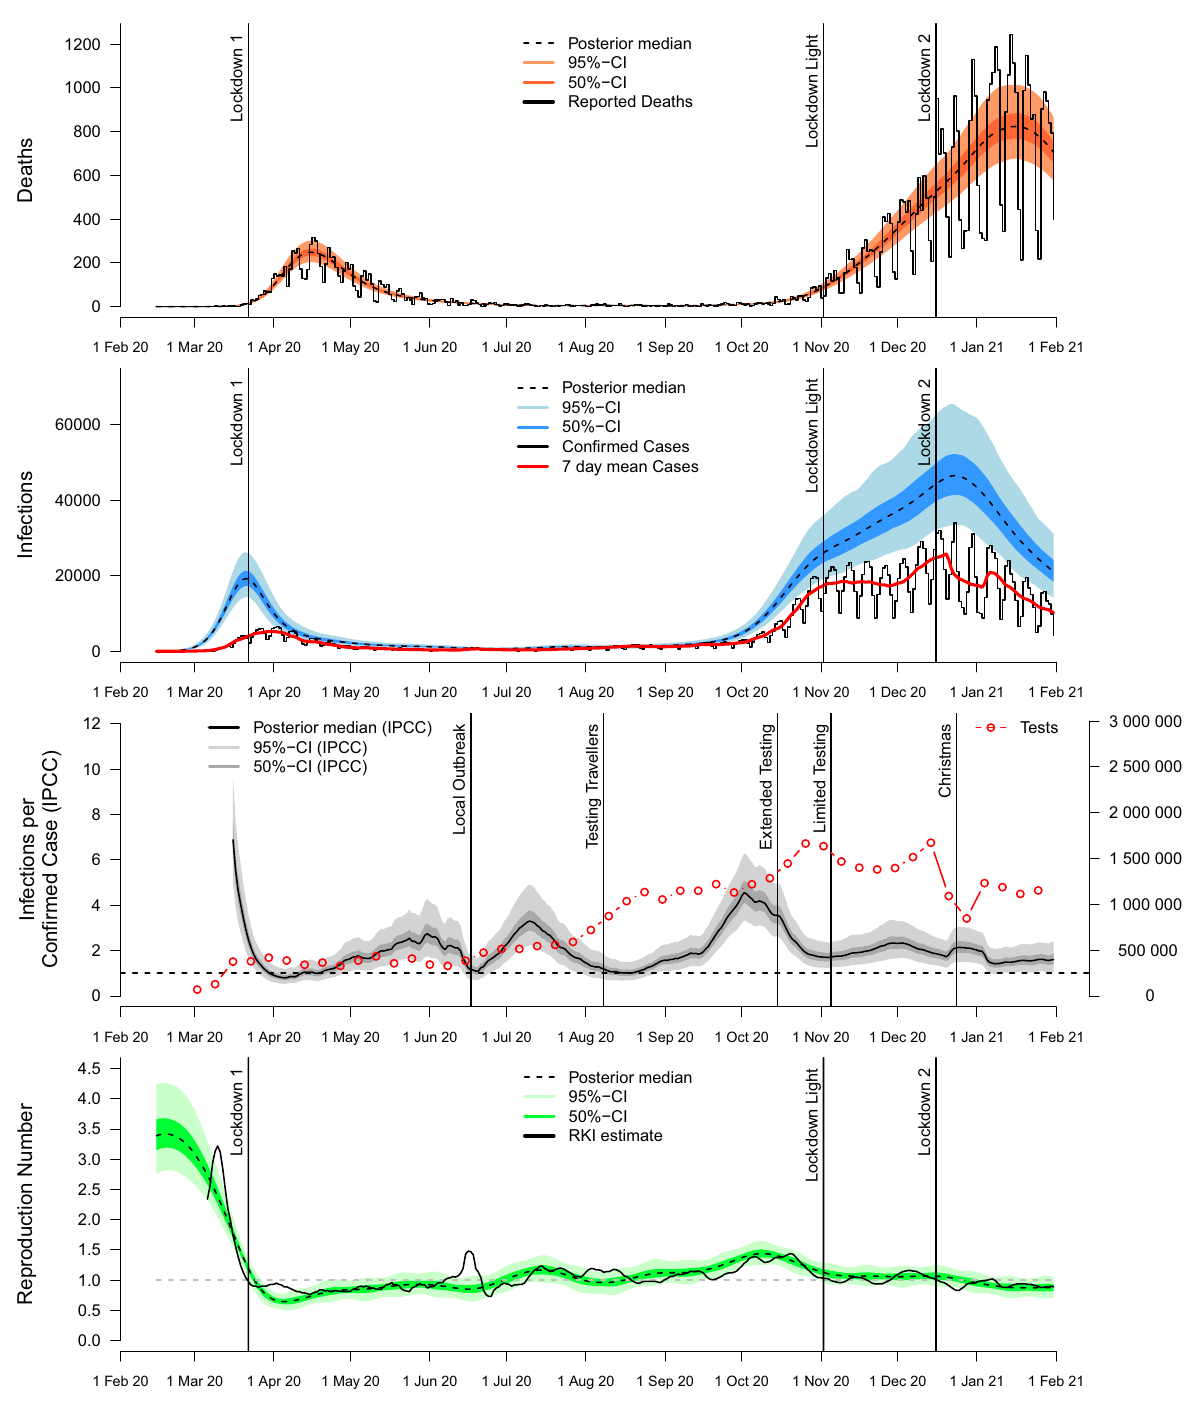
Figure 2. Results for the course of the COVID-19 pandemic in Germany via spline-based hierarchical modelling of death counts (cf. Fig. 1) using age-specific IFR estimates from Brazeau et al. 24 . Our model provides estimates of total numbers of infections over time (second graph) and of infections per confirmed case (IPCC) as a time-varying factor for dark figures of infections (third graph). By disentangling effects of changes in testing from transmission dynamics, estimates of our model for the effective reproduction number based on death counts tend to be more robust compared to RKI estimates based on confirmed cases (fourth graph). Model estimates are based on posterior medians, together with 50% and 95% credible intervals